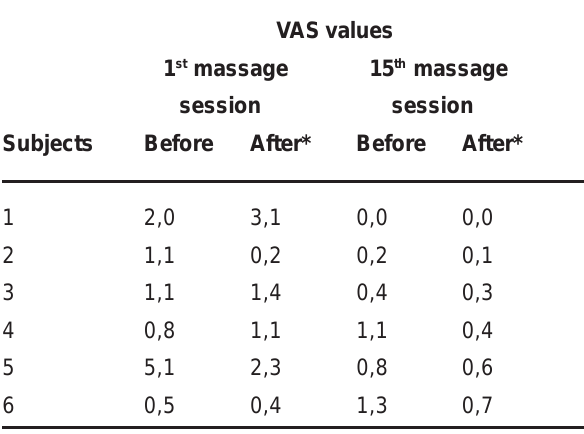
TABLE 2- VAS values of 6 subjects before and after massage